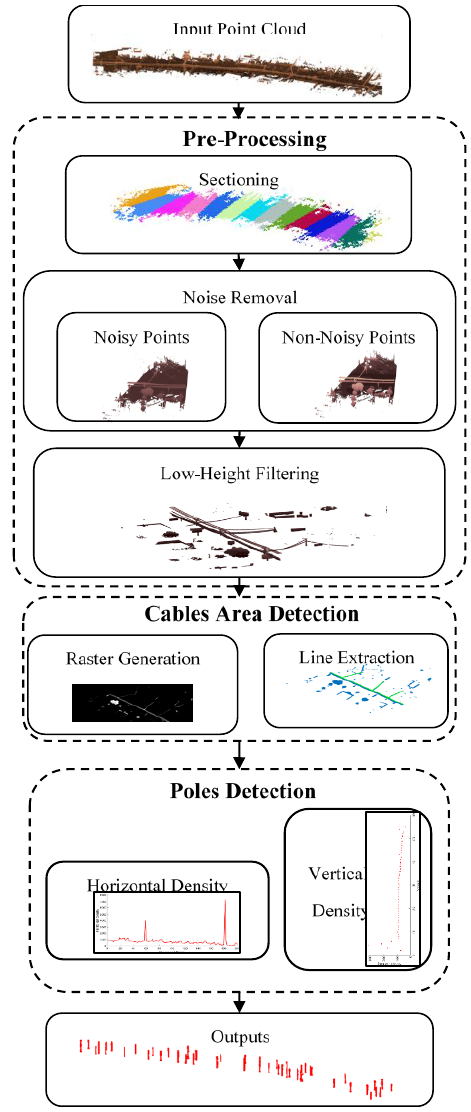
Figure 2. The flowchart of the proposed algorithm for poles extraction .